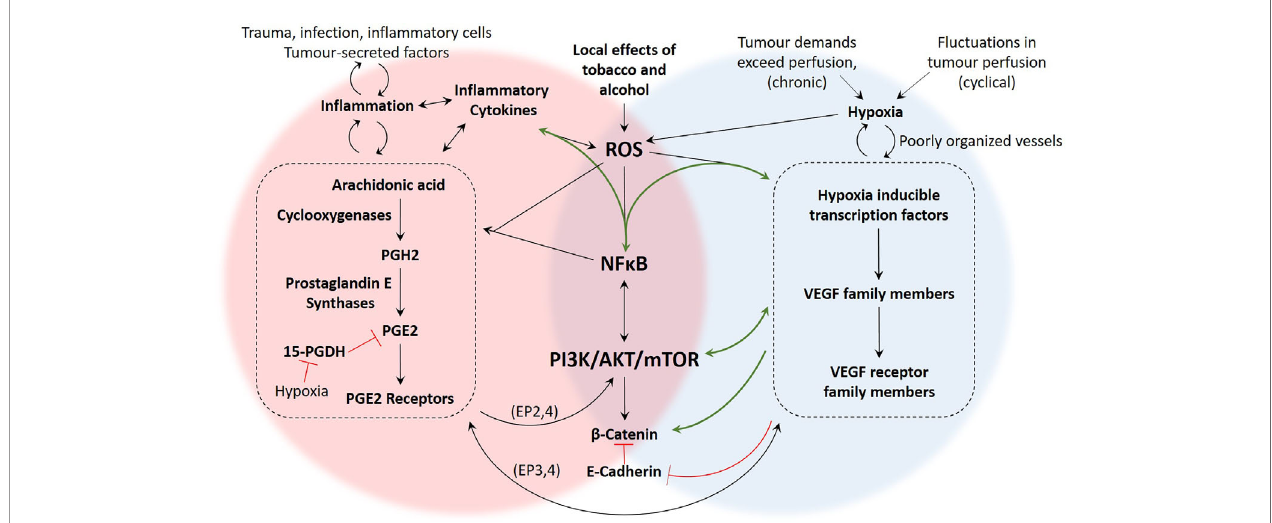
FIGURE 5 | Summary of proposed mechanisms linking in fl ammation and hypoxia in OSCC. There are several studies demonstrating the presence and function of the molecular components of these pathways in OSCC, yet mechanistic studies investigating how these pathways intersect during hypoxia and in fl ammation are more limited. The green arrows represent pathways that have been demonstrated in OSCC studies such as (10, 21, 27, 28, 41). The black arrows are pathways that have been demonstrated in non-OSCC studies, including (26, 62, 110, 125, 134). The signalling pathways associated with hypoxia-driven angiogenesis and the COX2/PGE2 axis of in fl ammation are numerous and our understanding is constantly evolving. However, based on the literature, important areas of overlap between in fl ammation and hypoxia include generation of ROS, activation of NF k B, signalling through the PI3K/Akt/mTOR pathway, and activity of b